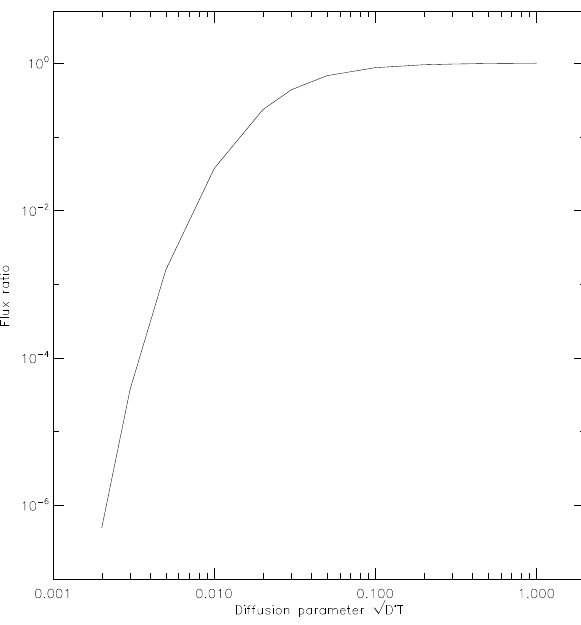
Figure 8: Ratio between precipitated and trapped electron fluxes (each integrated across their respective detec- Fig. 8. Ratio between precipitated and trapped electron fluxes (each tors) as a function of diffusion parameter. integrated across their respective detectors) as a function of diffu- sion Figure 6: Variation of 38.2 MHz absorption with (a) precipitated count rate P 30 (/sec), (b) trapped count rate Fig. 6. Variation of 38.2MHz absorption with (a) precipitated count √ T 30 (/sec), and (c) √ P 30 .T 30 , for 10 selected passes in the morning, noon and night sectors, showing individual P 30 T 30 , for rate P 30 (/s), (b) trapped count rate T 30 (/s), and (c) passes colour-grouped in local time, regression lines for the population as a whole (x-on-y and y-on-x as solid lines, 10 selected passes in the morning, noon and night sectors, showing individual passes colour-grouped in local time, regression lines for geometric mean as a dotted line), square law ‘rails’ (dashed lines) for comparison, and correlation coefficients for the population as a whole (x-on-y and y-on-x as solid lines, geo- each local time group, and the population as a whole. metric mean as a dotted line), square law “rails” (dashed lines) for comparison, and correlation coefficients for each local time group, and the population as a whole.